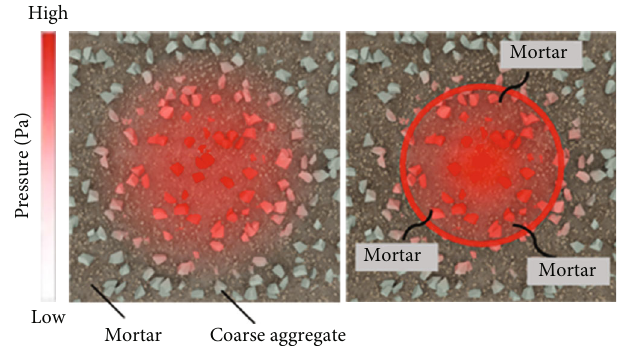
Figure 3: Conceptual diagram of the segregation